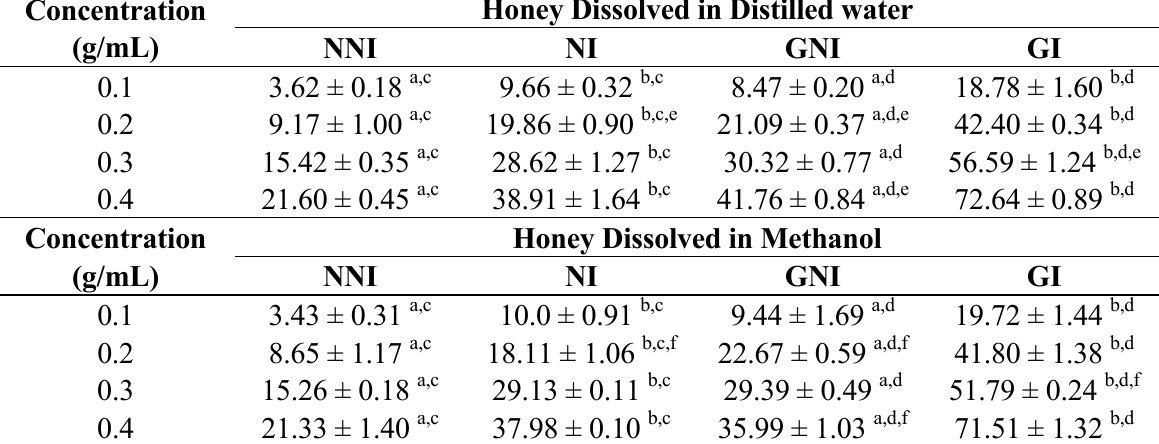
Table 4. Total phenolic contents (mg Rutin equivalent/100 g) of Gelam and Nenas honeys before and after